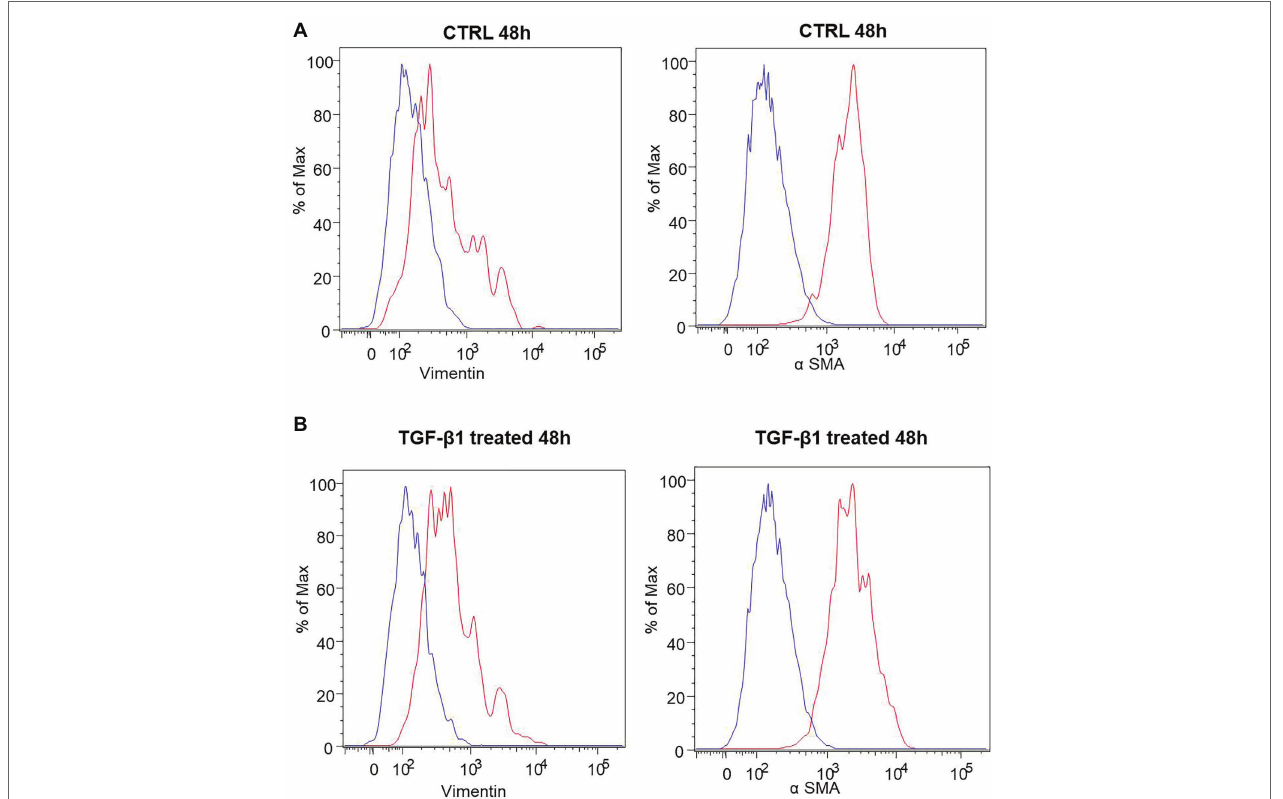
FIGURE 3 | Human GFs characterization. (A) Flow cytometry immunophenotype analysis of untreated hGFs (CTRL) and hGFs after 48 h of TGF- β 1 treatement (TGF- β 1 treated). Anti-Vimentin or anti- α SMA stained cells are represented as red histograms. The related controls (cells stained with the secondary antibody alone) are represented as blue histograms. (B) Flow cytometry immunophenotype analysis of hGFs (CTRL) and hGFs after 72 h of TGF- β 1 treatement (TGF- β 1 treated). Anti-Vimentin or anti- α SMA stained cells are represented as red histograms. The related controls (cells stained with the secondary antibody alone) are represented as blue